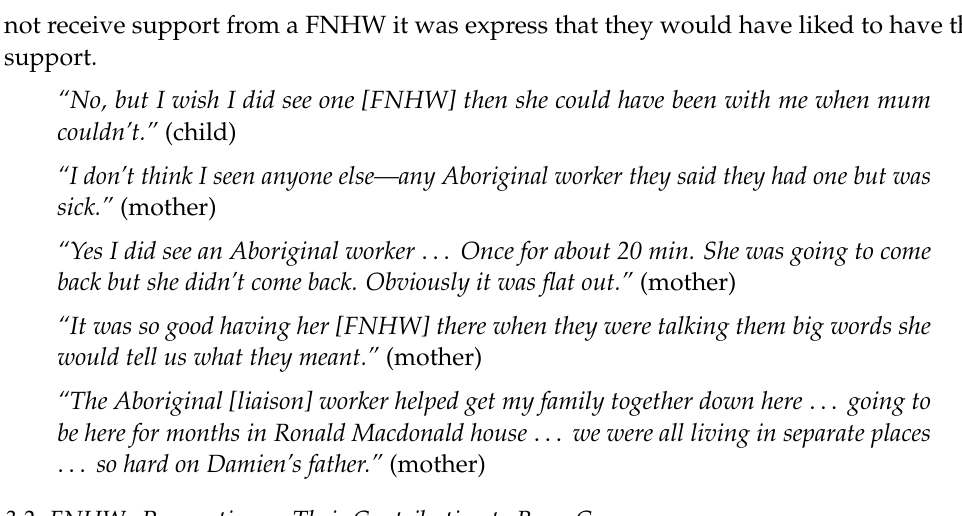
Table 2. First Nations health workers’ perspectives on their contribution to and challenges with burn care. Tangible Support Cultural Support Two Worlds Working Connection to people and